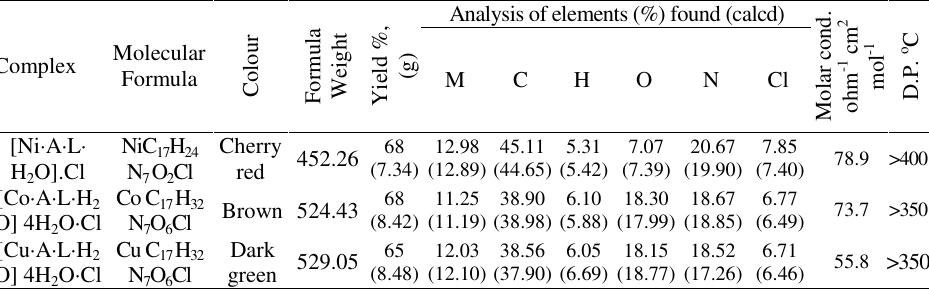
Table 1. Analytical data and some physical properties of the metal complexes